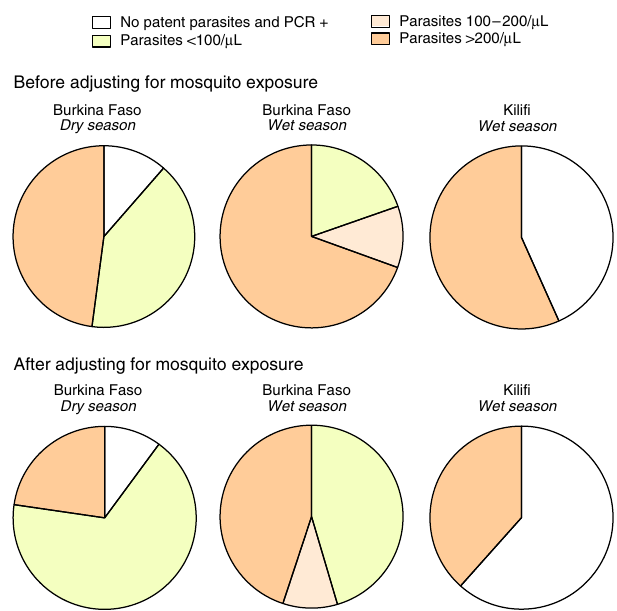
Fig. 4 Proportion of infected mosquitoes by parasite density. Age-speci fi c prevalences of falciparum malaria parasites by microscopy and PCR and infectiousness prevalences by microscopy-de fi ned parasite density were used to estimate the proportions of P. falciparum infected mosquitoes in each community; demographic age structure in Sub-Saharan Africa populations was used to standardise estimates. Individuals with evidence of non-falciparum malaria infections were excluded ( N = 2). The top panels represent the contributions of human infections with different parasite densities to local mosquito infections, after adjusting for population age structure and age-and-parasite density-speci fi c probabilities of mosquito infection in feeding assays; in the bottom panels, age-speci fi c relative mosquito exposure data were used. These calculations were based on 13, 12 and 3 infectious individuals and 108, 104 and 4 infected mosquitoes in the Burkina Faso dry and wet season surveys and in the Kili fi wet season survey, respectively. Data from Mbita are not presented as most infectious individuals in this setting had P. malariae